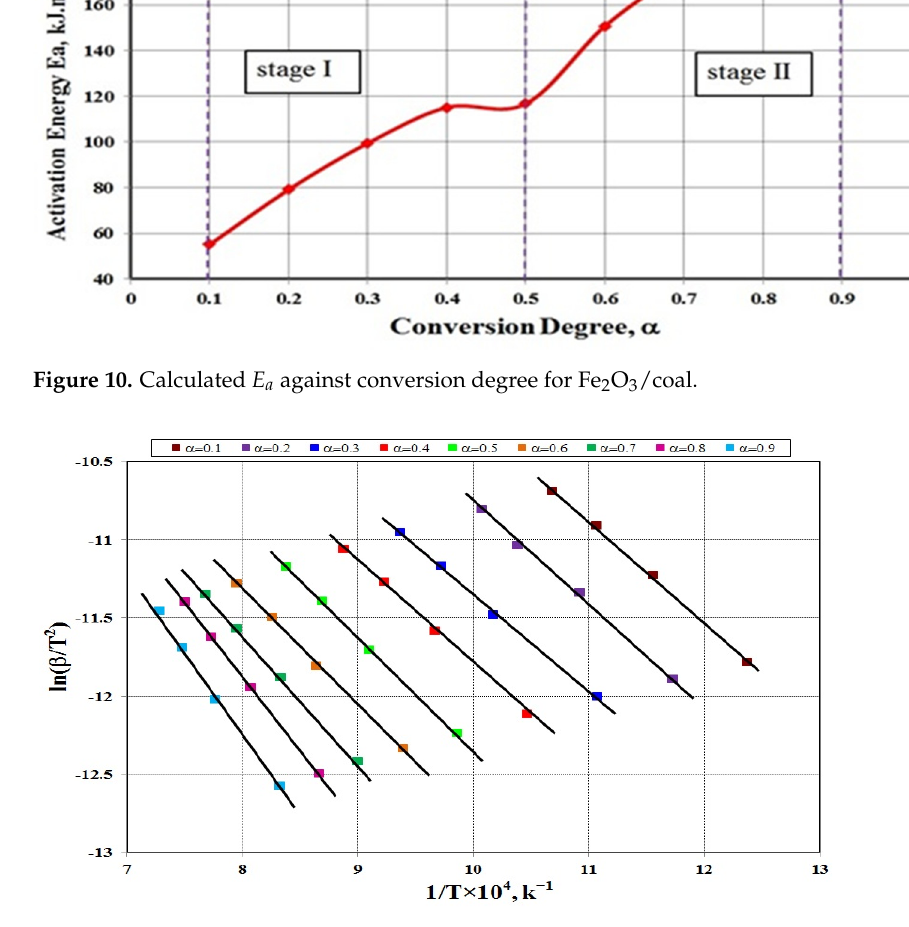
Table 5. Apparent activation energy values computed at overall reduction reaction.